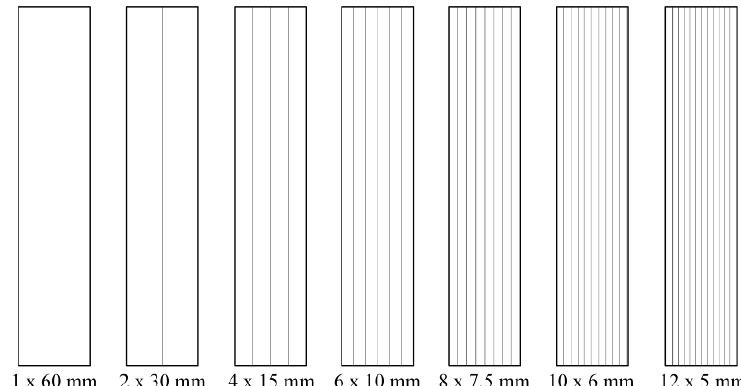
Figure 2. Strip assembly of the tested samples in the case of 60 mm × 300 mm total area.